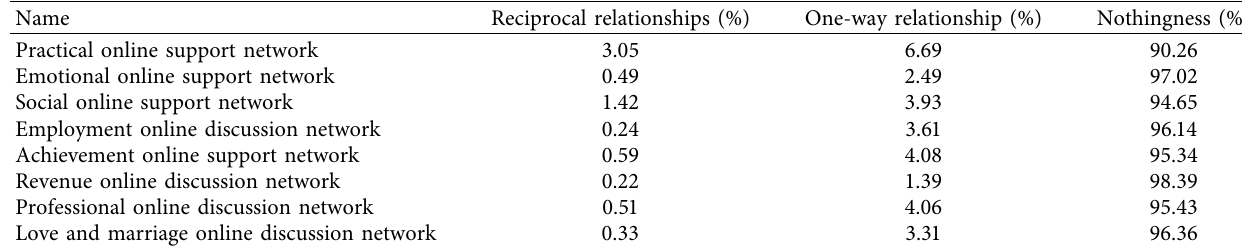
Table 5: Distribution of bipartite